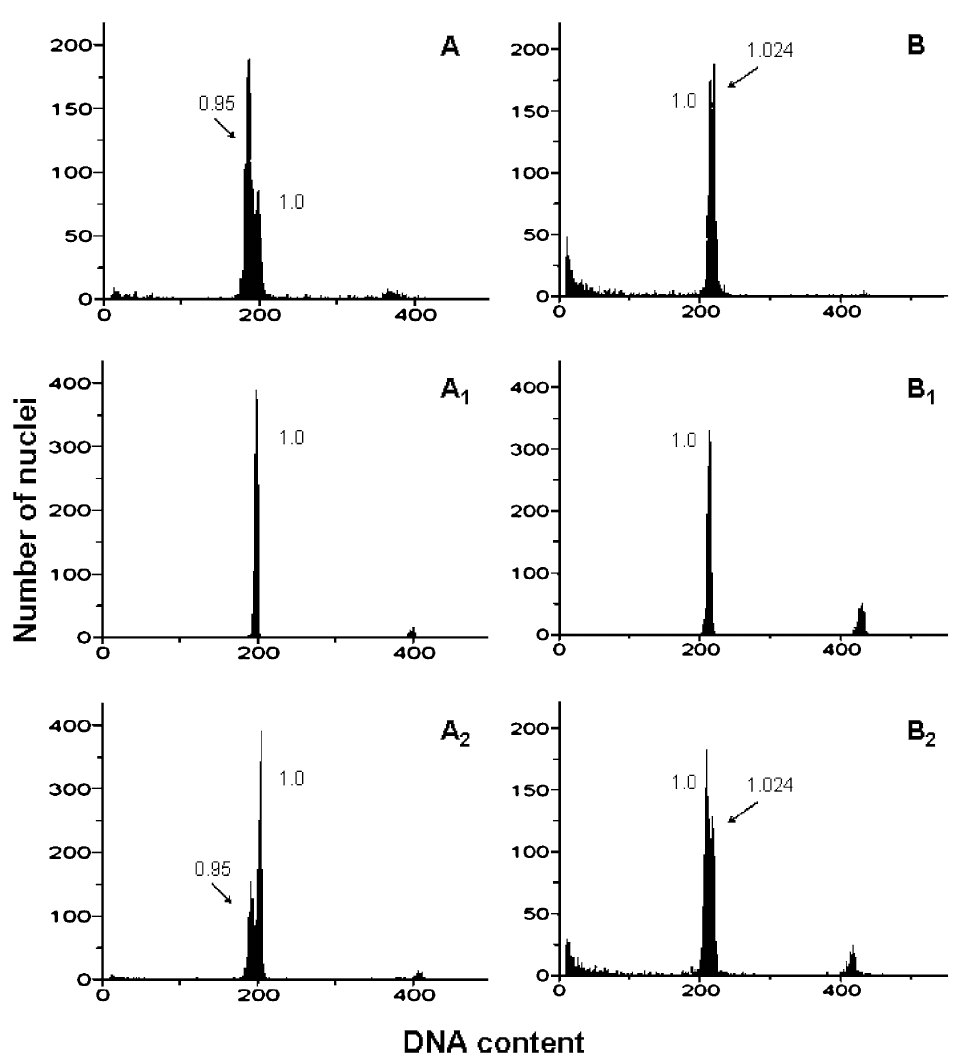
Fig. 1a. Examples of DNA content histograms from fresh/frozen oral mucosa/lesions as obtained by high resolution DNA FCM, which demon- strate the presence of DNA near-diploid aneuploid sublines (a)–(b) and high-aneuploid sublines (c). All FCM DNA content measurements were relative to internal normal diploid cells and/or sex specific externally added normal diploid cells. The calculation of the lesion DI values was therefore independent from the channel number position of the DNA diploid G0–G1 peak (near 200). During the time course of a set of FCM measurements, slight drifts of this peak could be observed from the initial position due to slight hydrodynamic and UV-lamp illumination changes. (A) Two G0–G1 peaks are visible at the channels 186 and 198; background formed by nuclei fragments is visible to the left of the peaks; S and G2/M nuclei are to the right. (A 1 ) Sex specific human lymphocytes of an healthy donor, used as DNA diploid control ( DI = 1), show a single G0–G1 peak at channel 198; CV was 0.93% by fitting and 0.86% by use of the width at 1 / 2 height peak formula (see Section 2); the comparably small CV values obtained for the DNA controls (A 1 , B 1 , C 1 , D 1 ) indicate that the DNA content FCM measurements were performed at high resolution; in addition, the small peaks of G0–G1 lymphocyte doublets at channels near 400 define a ratio to the diploid peak of exactly 2.0 as to be expected for an optimal linearity of the measuring system. Mixing at about 50% each of the oral lesion nuclei with the DNA diploid lymphocyte nuclei (respectively, A and A 1 ) produced the DNA histogram shown in A 2 . Comparison of the two clear-cut visible G0–G1 peaks in A and A 2 indicated that mixing produced a relative increase of the diploid peak-height (to the right) and a decrease of the other near-diploid (hypo-diploid) peak-height (to the left); one may conclude that the original cheek OPML contained a DI = 0 . 95 hypo-diploid subline character- ized by a 5% DNA content decrease relative to a sex specific diploid control. B and B 2 show, similarly, two G0–G1 DNA near-diploid sublines from a tongue OPML. Following exactly the same analysis as detailed for the previous case, one ends-up with the interpretation that the original OPML contains a near-diploid hyper-diploid DNA subline with DI = 1 . 024 (i.e., with a 2.4% DNA content increase with respect to the sex specific DNA diploid